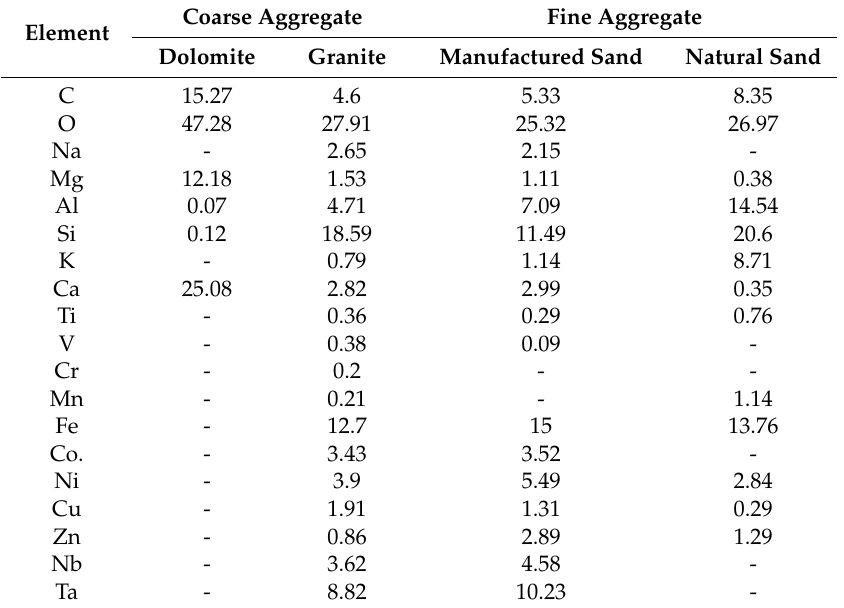
Table 4. Chemical compositions of aggregates (% by weight).